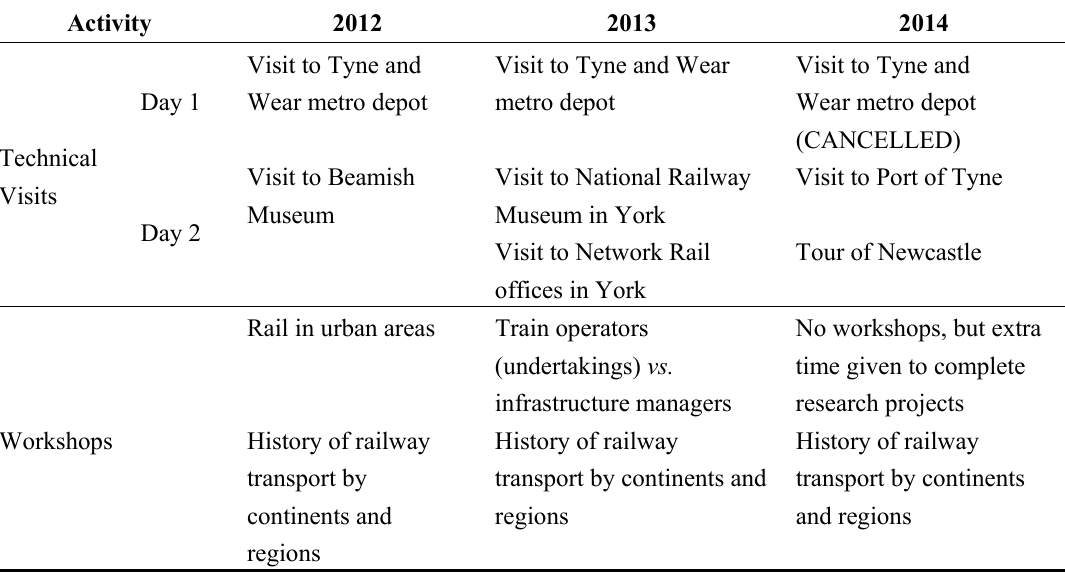
Table 3. Technical visits and workshops included in the